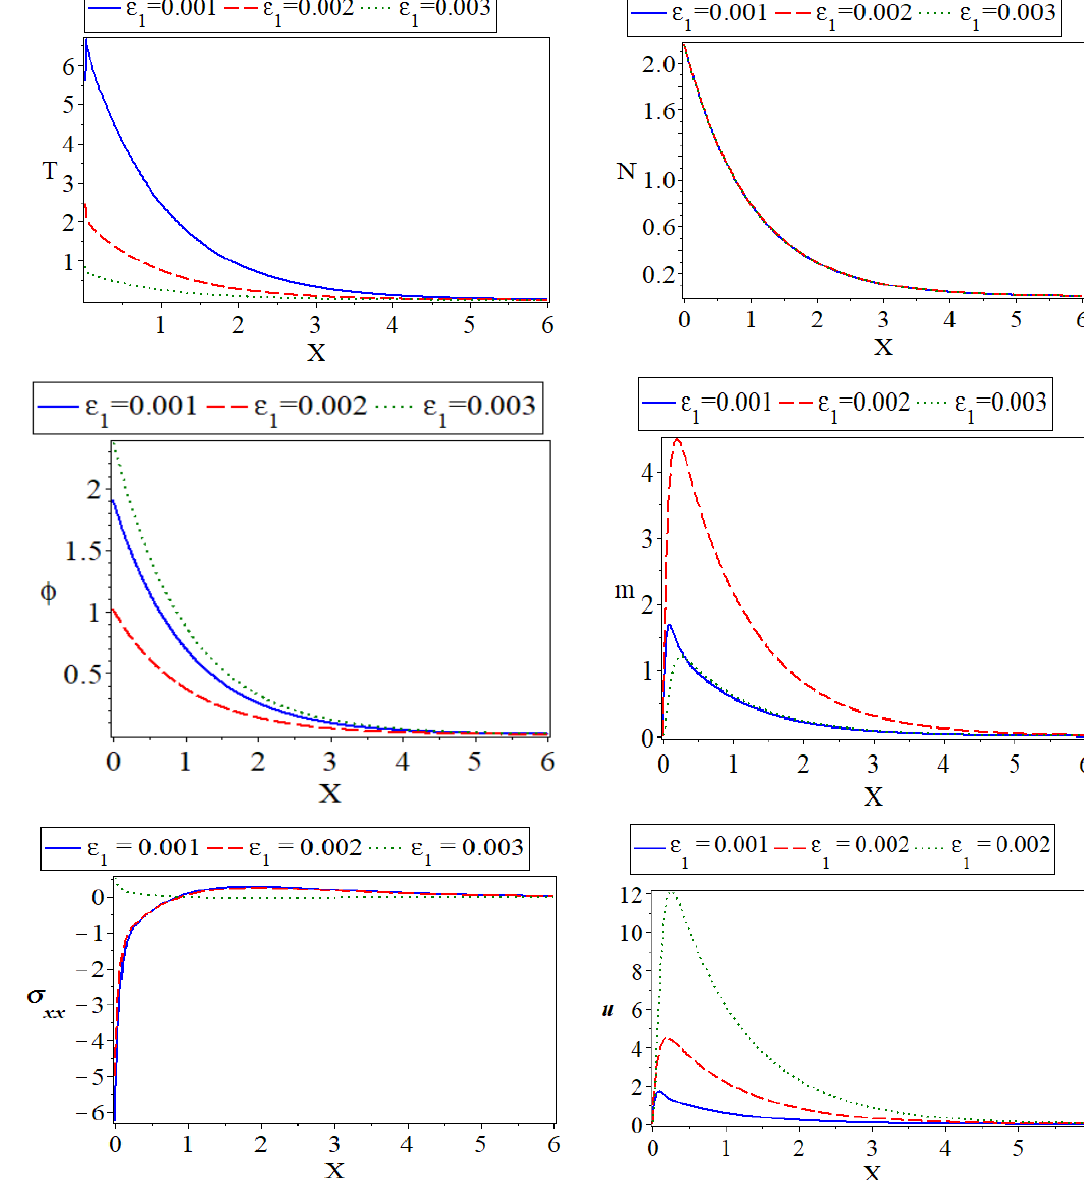
Figure 3. The variation of physical field distributions with distance at different values of thermo- elastic coupling parameter ε 1 under the effect of moisture field and ε 3 = − 7.8 × 10 − 36